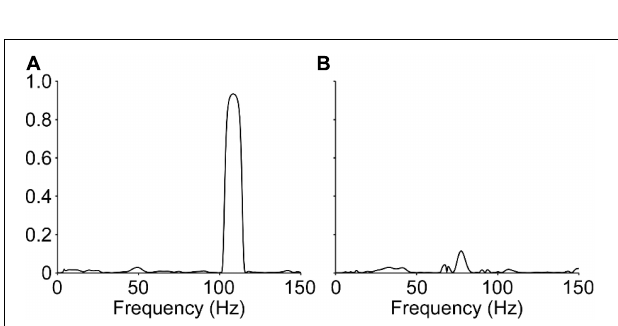
FIGURE 6 | Coherence between the neural drive to muscle and the vibration frequency. Representative data showing the coherence between the composite spike train and the vibration frequency, determined through the force signal, are shown for the cat (A) and human (B) . The data from the cat show relatively large coherence (0.93) at the vibration frequency, however, data from the human shows a stark reduction, but not complete abolishment, of the observed coherence (0.11) at the vibration